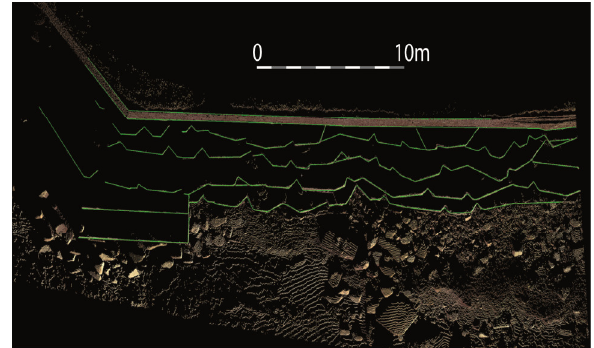
Figure 4. Digitisation of sea wall defences from TLS data © CDDV 2011.